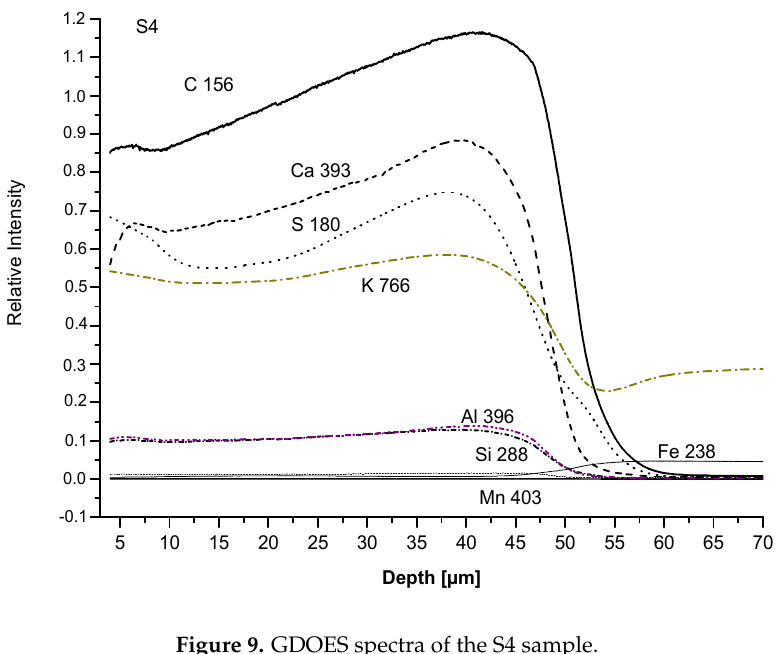
Figure 9. GDOES spectra of the S4 sample. Coatings 2017 , 7 , 213